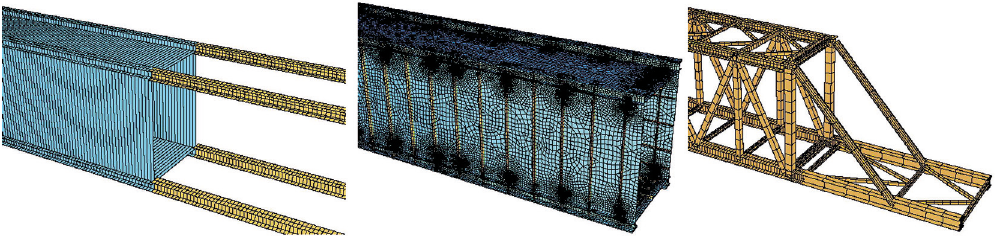
Figure 1. From left to right: Linear beam elements for the whole MSS, shell elements for the MSS box section, 3D beam elements for the MSS